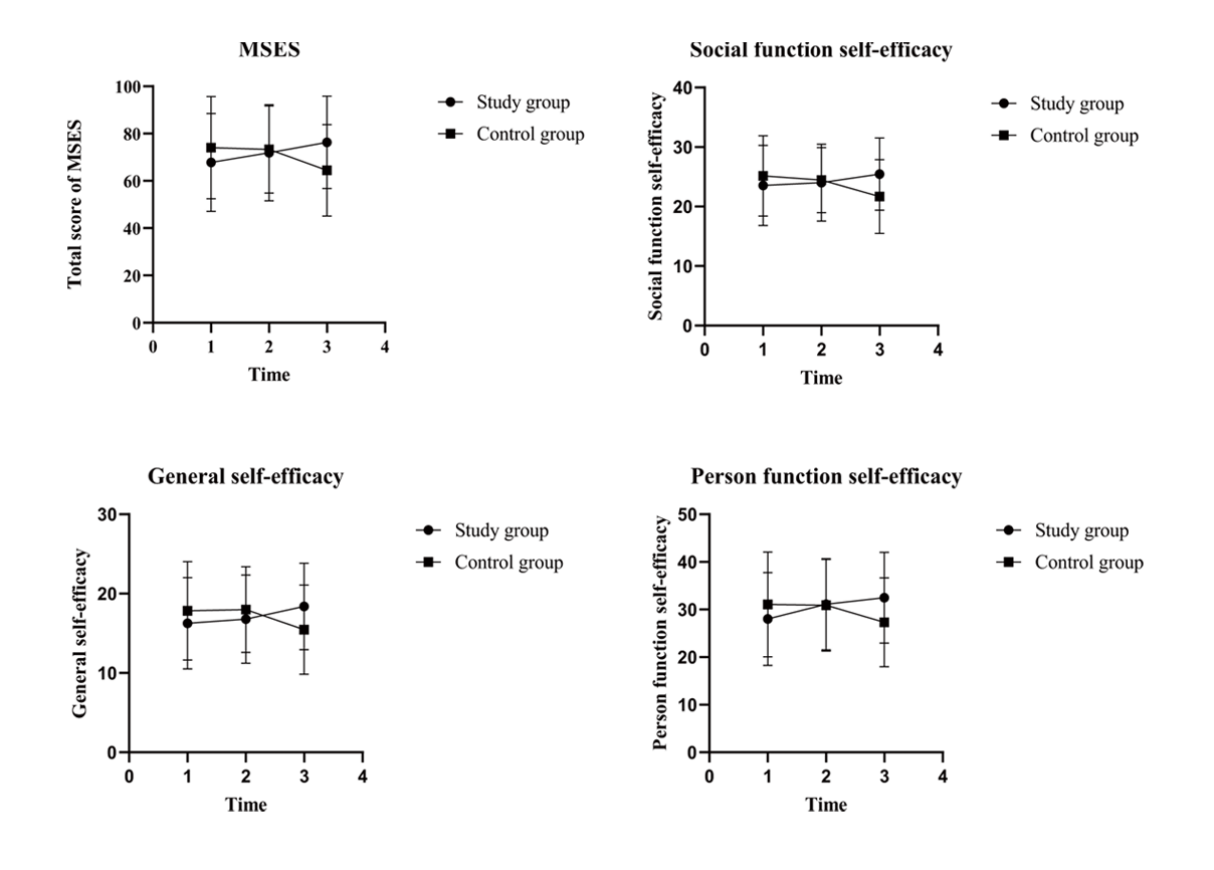
Figure 5. Trend charts of total Moorong Self-efficacy Scale (MSES) scores and scores of three-factor structures. Time 1: prior to discharge (baseline); time 2: at 12 weeks following discharge; time 3: at 24 weeks following